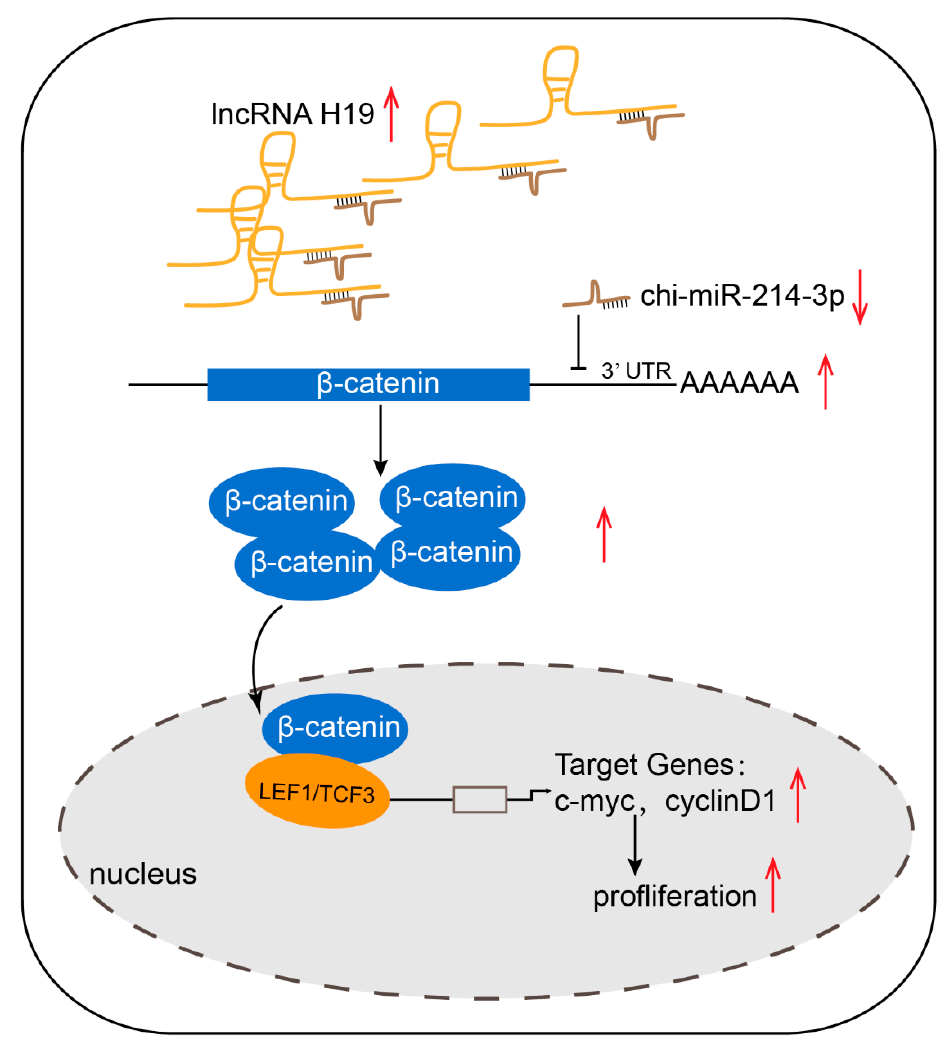
Figure 7. Model of H19 regulating the proliferation of cashmere goat dermal papilla cells. Red arrow up means increase, arrow down means decrease.